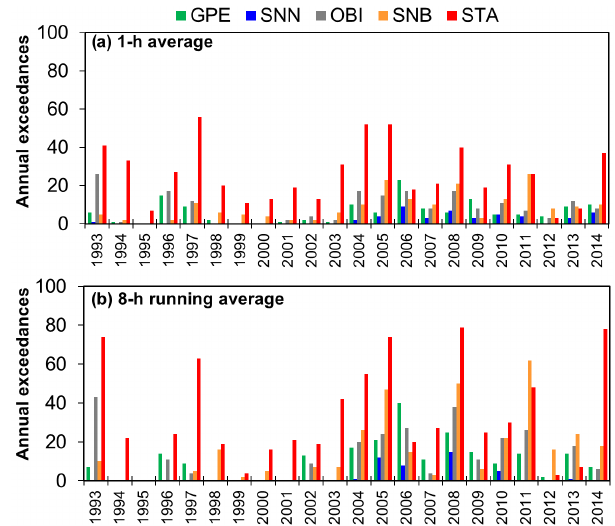
Figure 11. Annual exceedances of the O 3 NOM for 1h averages (110ppb) and 8h running averages (80ppb) at the five monitoring sites within the MMA from 1993 to